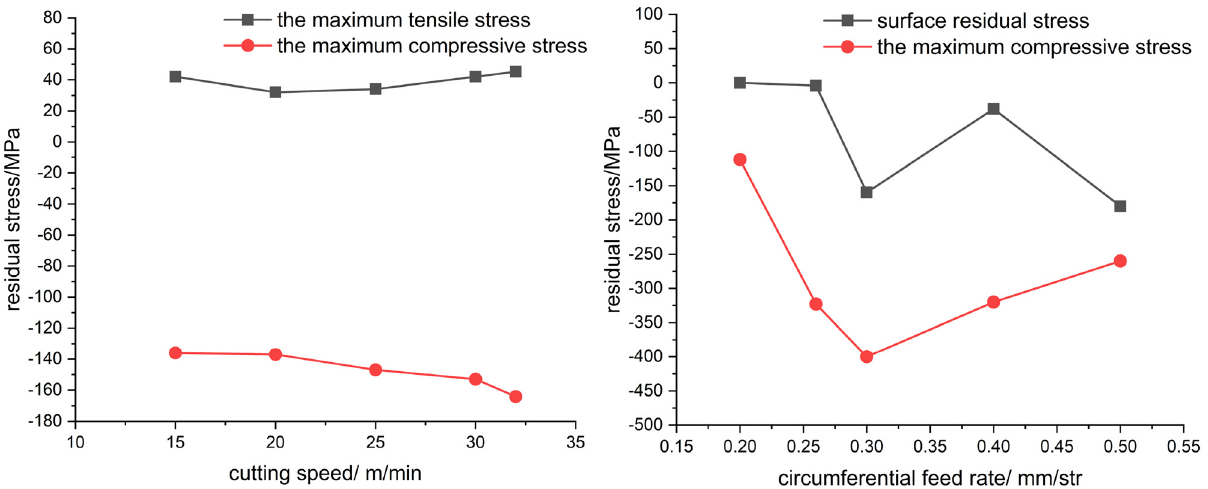
Figure 8: The e ff ect of cutting speed and circumferential feed rate on residual stress.